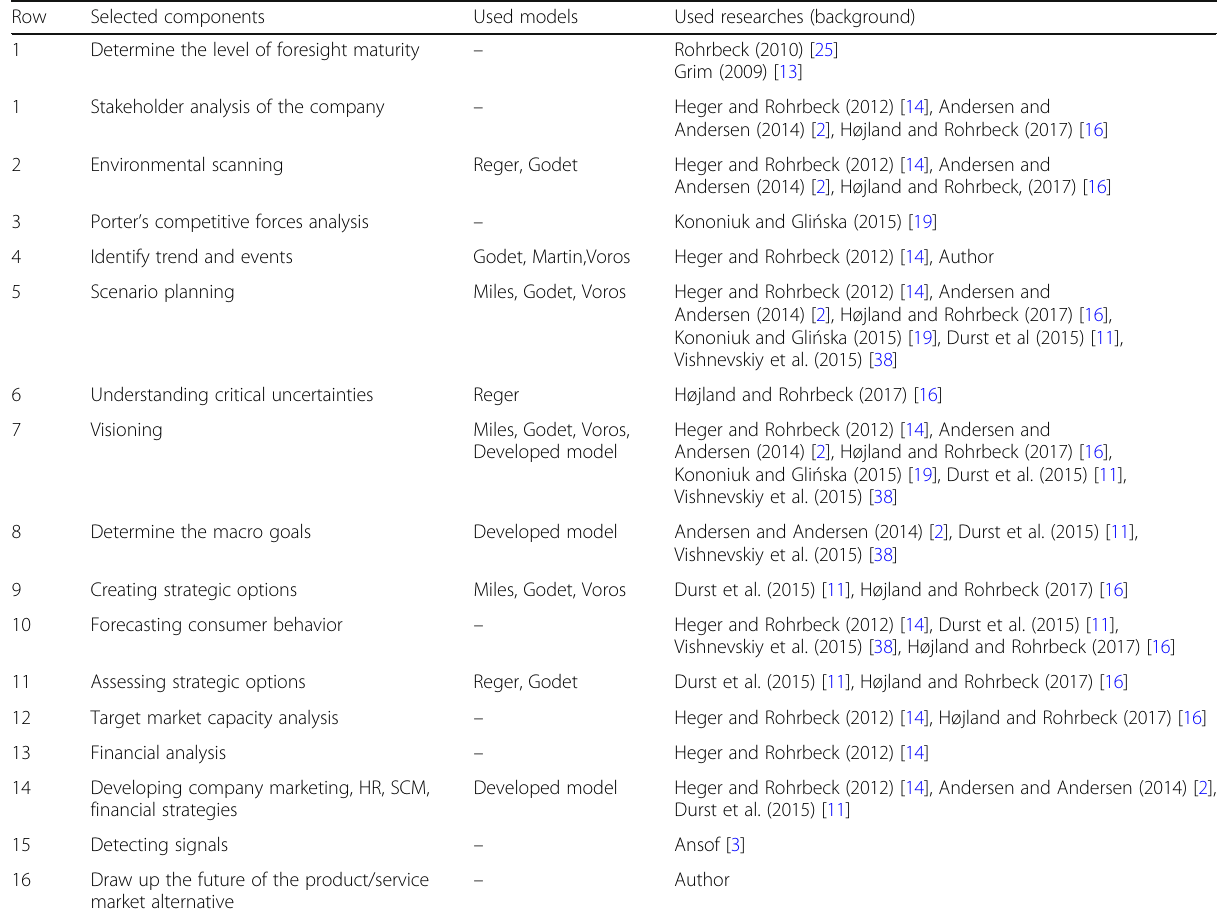
Table 4 Selected